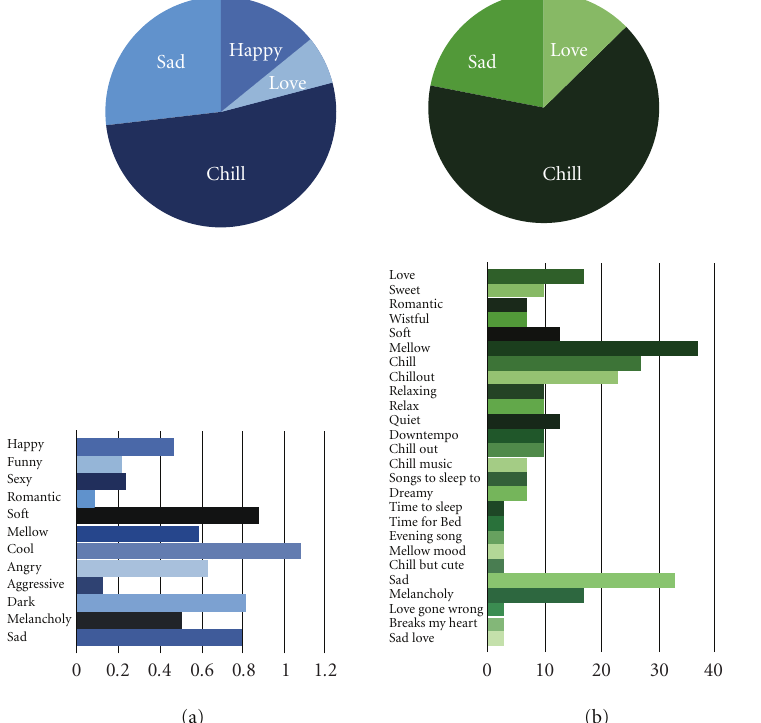
Figure 2: Accumulated LSA correlation between (a) the lyrics of the song “Now at last” and 12 a ff ective terms, compared to (b) the actual user-defined emotional tags at